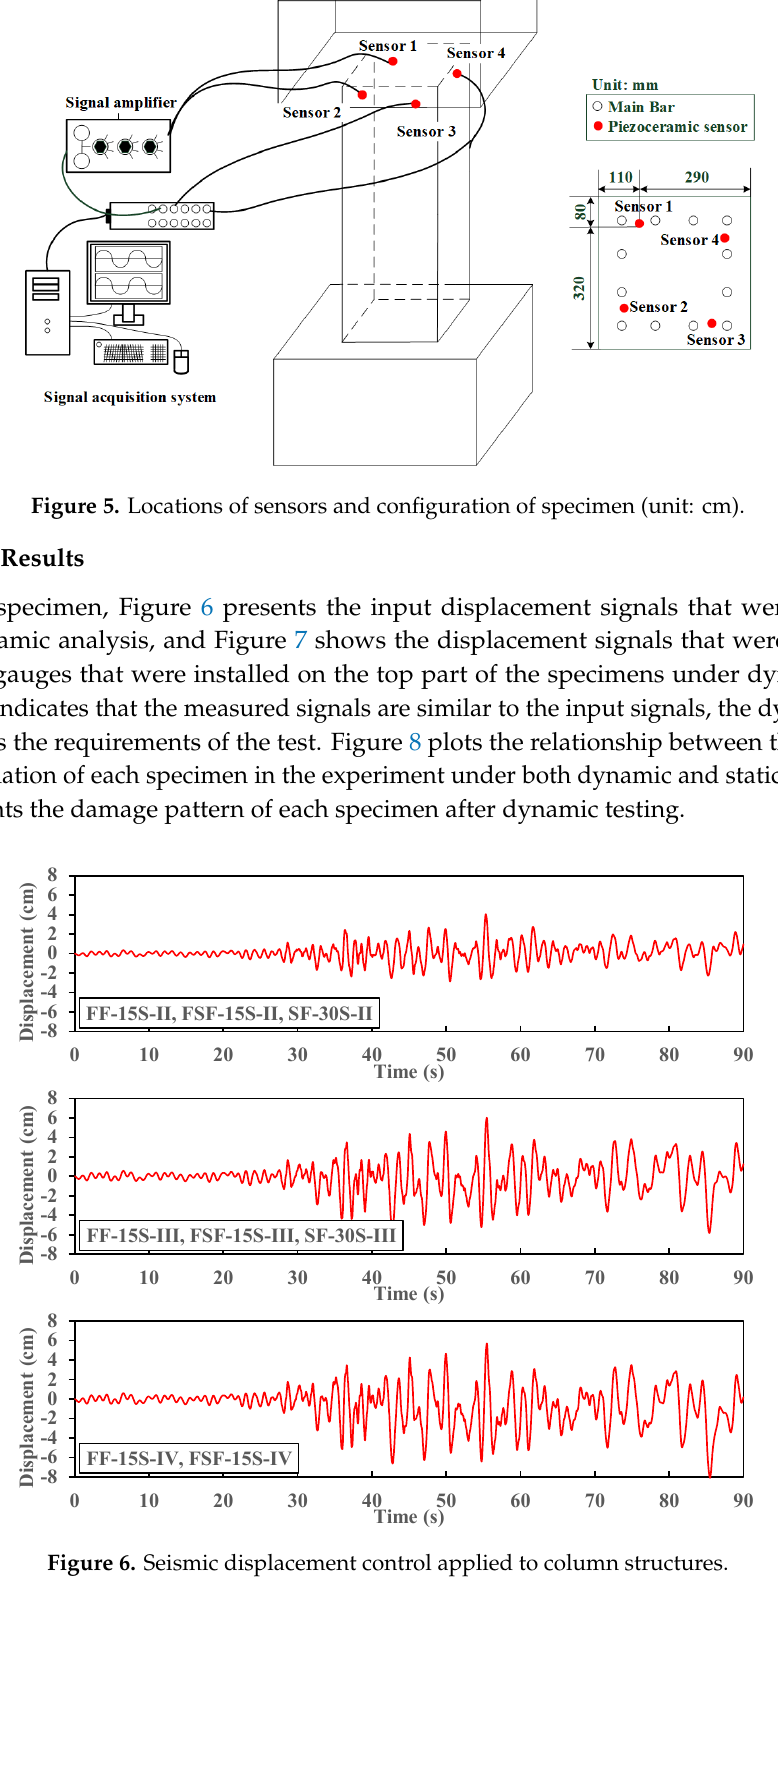
( c ) Figure 7. Comparison of input and output displacement histories. ( a ) Displacement = 4 cm; ( b ) Displacement = 6 cm; ( c ) Displacement = 8 cm. Table 3. Performance points of each specimen under different loading scheme. Specimen